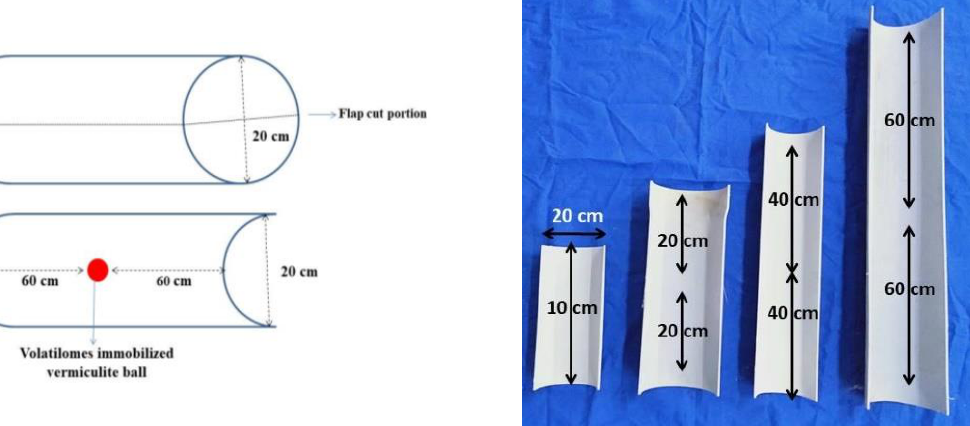
Figure 8. Model of olfactory chamber.